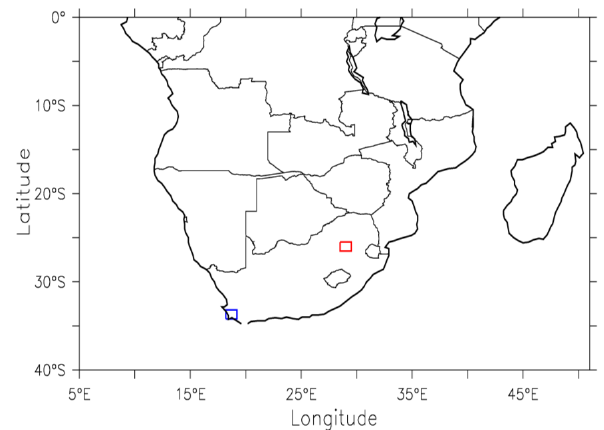
Figure 1: Map of southern Africa showing Cape Town area (blue box) at the south western tip of Fig. 1. Map of southern Africa showing the Cape Town area (blue South Africa and the Mpumalanga Highveld (red box), the most industrialised area in South box) at the southwestern tip of South Africa and the Mpumalanga Africa, at north eastern part of South Africa. Highveld (red box), the most industrialised area in South Africa, in the northeastern part of South